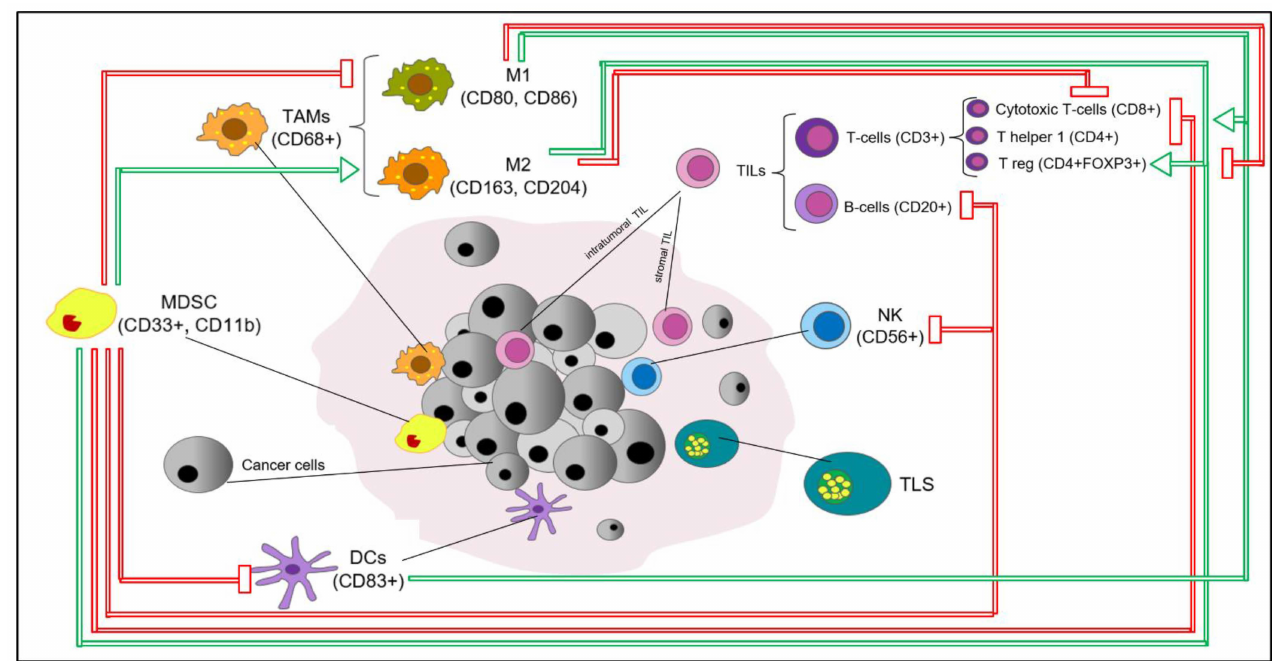
Figure 1. Key immune cell subsets in breast cancer tumor microenvironment. The production of IFN γ by CD4+ Th1 cells mediates the expansion, differentiation and activation of CD8+ tumor-infiltrating lymphocytes (TILs), which subsequently release cytotoxic cytokines and directly kill cancer cells (via recognition of specific tumor-associated antigens on the surface of antigen presentation cells (APCs) or cancer cells); CD4+FOXP3+ TILs represent immunosuppressive mediators through the inhibition of CD8+ T cells, CD4+ Th1 cells, APCs and natural killer cells (NKs); M1 tumor-associated macrophages (M1-TAMs) are associated with Th1 cytotoxic immune response, thus exhibiting antitumor properties; M2-TAMs contribute to the activation of Th2 immune response, thus showing an immunosuppressive role (e.g., suppression of T cell function); NKs are cytotoxic members of the innate immune system (release of cytotoxic cytokines and direct killing of cancer cells); dendritic cells (DCs) are antigen-presenting cells and are crucial players of the adaptive immune system; myeloid- derived suppressor cells (MDSCs) represent immature myeloid cells (possibly originated from bone marrow precursors) with an immunosuppressive function via the inhibition of T cells, B cells, NKs, M1-TAMs and DCs. The recruitment and accumulation of immunosuppressive mediators into the tumor bed is mediated by the secretion of cytokines and chemokines (e.g., IL6, IL1- β , TGF-1 β , CCL2) by tumor cells. Red and green arrows reflect inhibitory and stimulatory relationships, respectively. Abbreviations: IFN γ , interferon gamma; TILs, tumor-infiltrating lymphocytes, APCs, antigen presentation cells, NKs, natural killer cells, DCs, dendritic cells, TAMs, tumor-associated macrophages; MDSCs, myeloid-derived suppressor cells; TLS, tertiary lymphoid